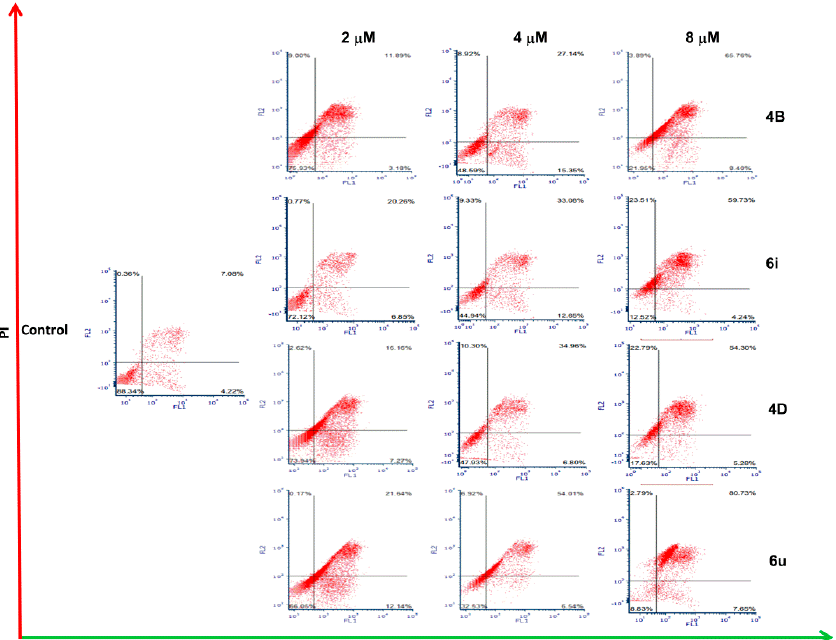
Figure 3. The cell apoptosis was detected by flow cytometry using Annexin V-FITC/PI dual staining. A549 cells were treated with 4B , 6i , 4D , and 6u at 2, 4, and 8 µ M for 48 h, and then stained with Annexin V-FITC and PI for 15 min at 37 ◦ C. The proportions of the living cells, the early apoptosis cells, and the late apoptotic cells were analyzed by FCS Express 5.0. Table 3. The percentage of cell apoptosis of A549 cells at indicated compound concentrations ( 4B , 6i , 4D , and 6u at 2, 4, and 8 µ M).